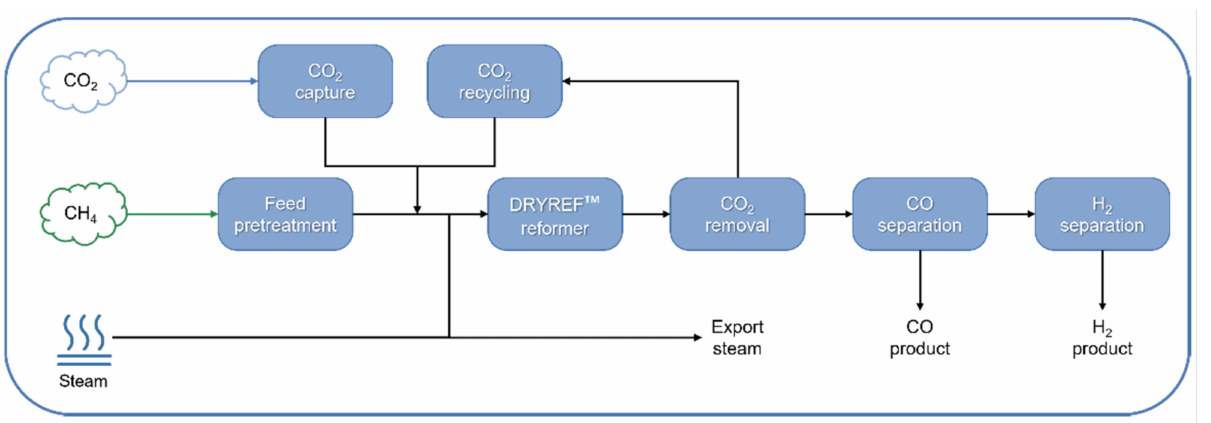
Figure 9. Simplified block diagram of the MIDREX™ process for metallic iron production [159].